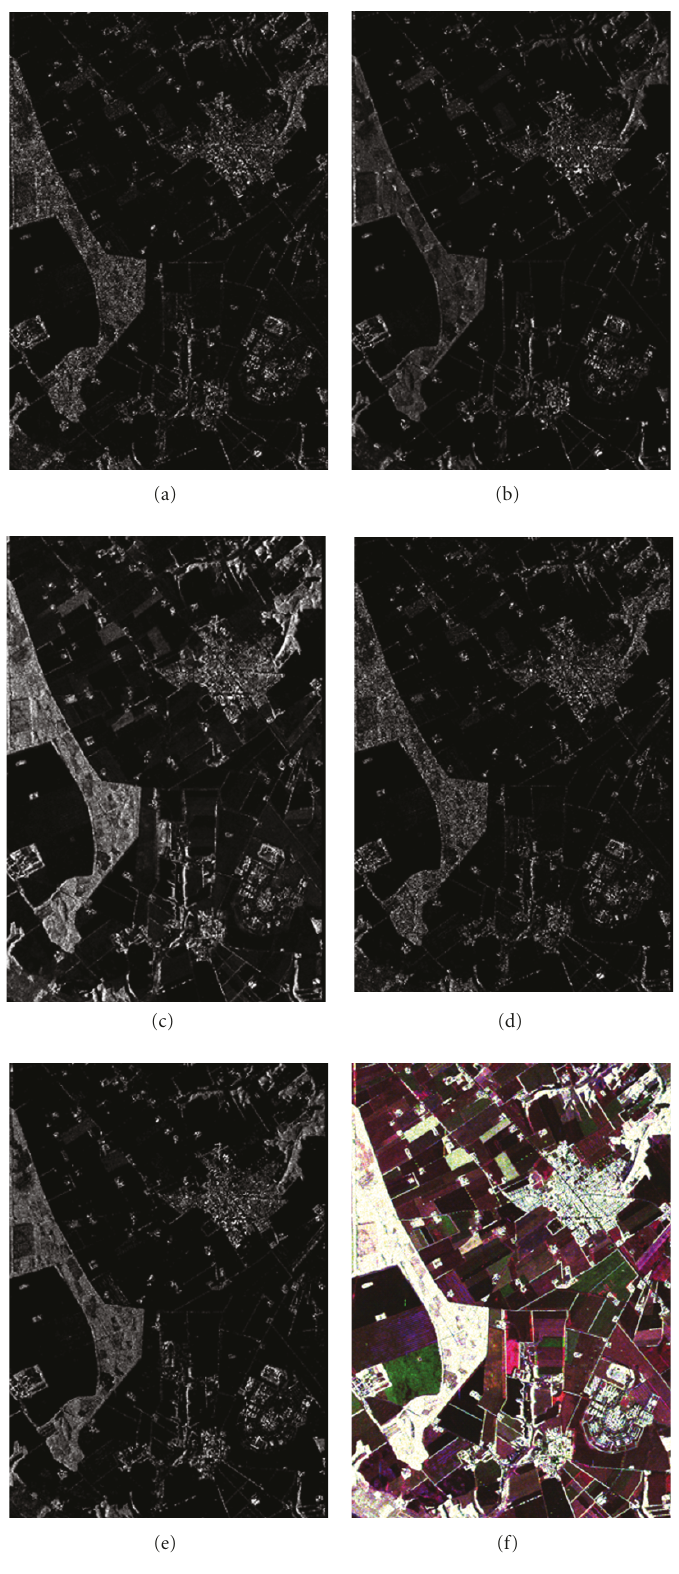
Figure 3: Polarimetric decomposition image of MCSM: (a) power image of P s , (b) power image of P d , (c) power image of P v , (d) power image of P h , (e) power image of P w , (f) pseudo-colour decomposition result; the image is colored by P d (red), P v (green), and P s